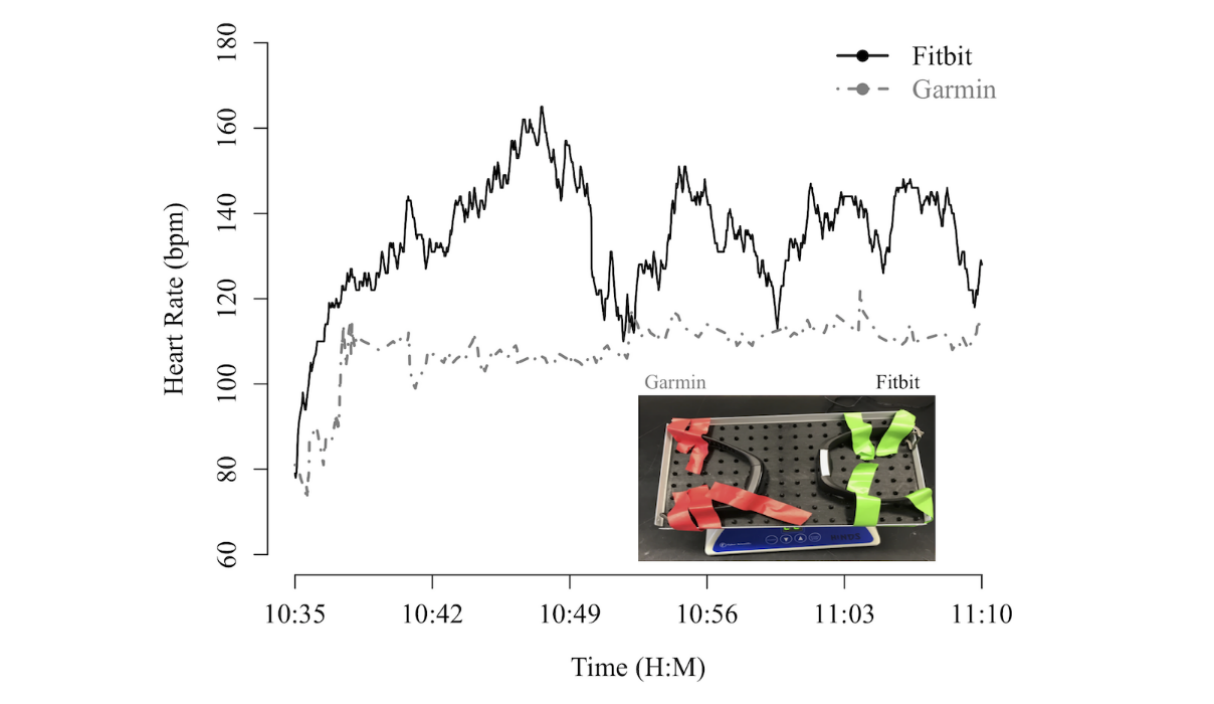
Figure 8. Spurious heart rate measured by the Garmin and Fitbit devices when placed on a shaker device (image of the experimental setup in the inset). H:M is